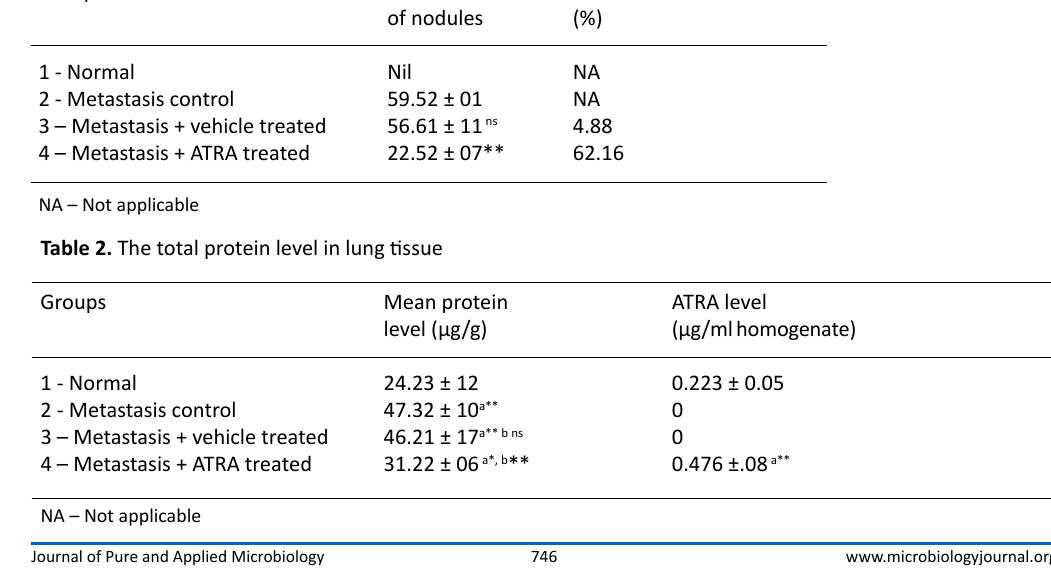
Table 1. Number of nodules found on lung and the percent inhibition by ATRA Groups